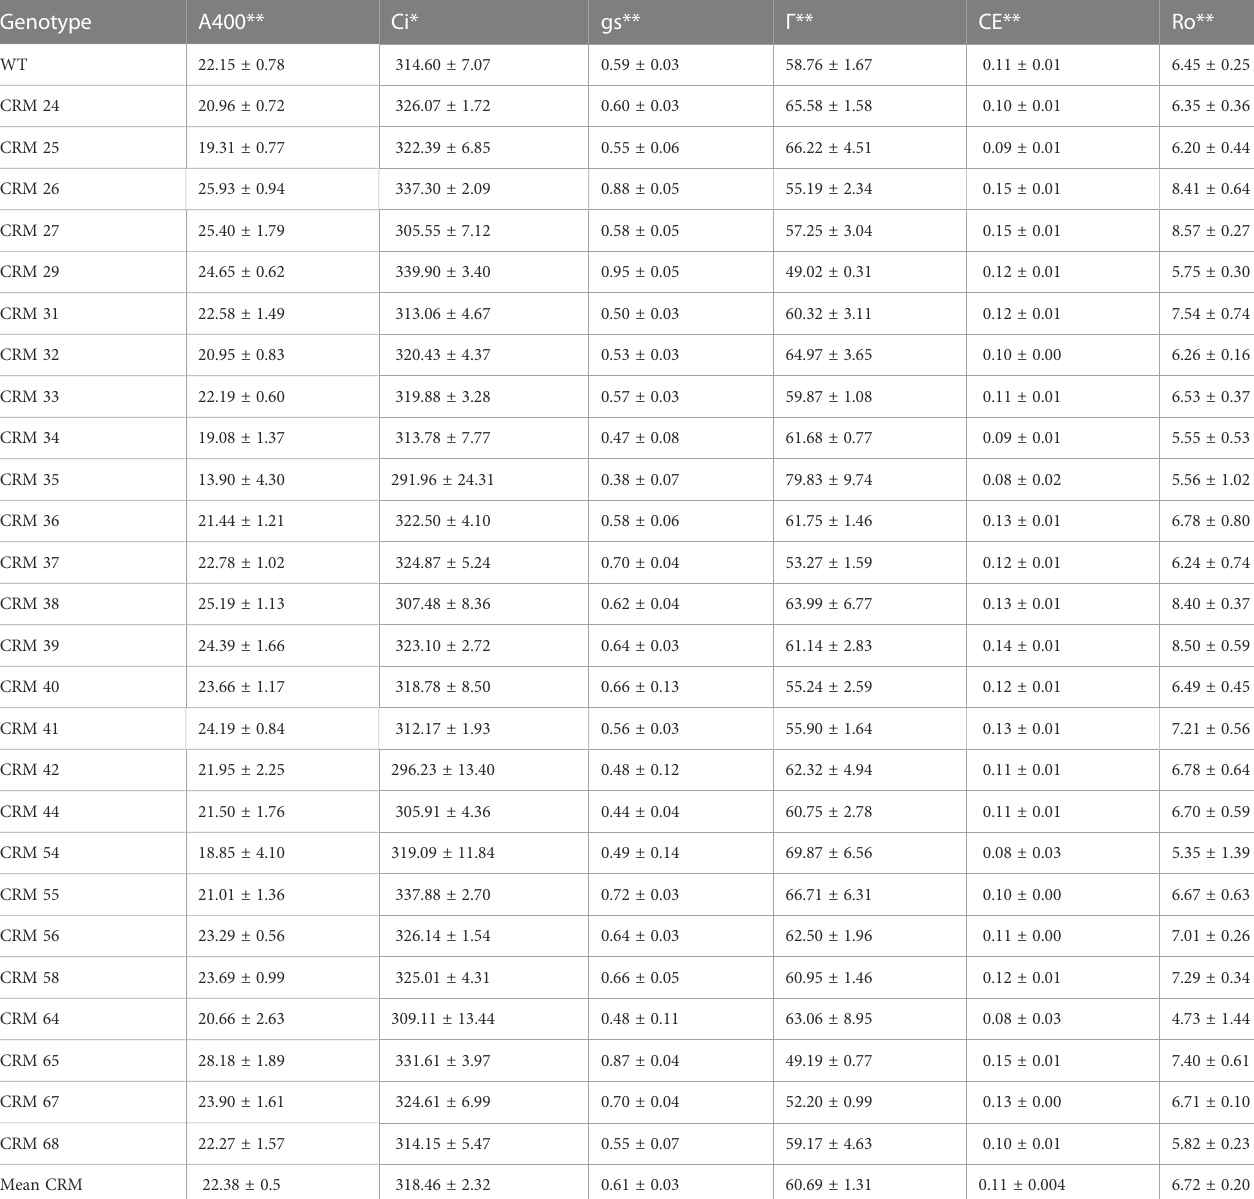
TABLE 2 Photosynthetic traits of chlorophyll retention mutant (CRM) rice lines relative to the parental wild type (WT) IR64 from spot measurements and ACi curves. Genotype A400**